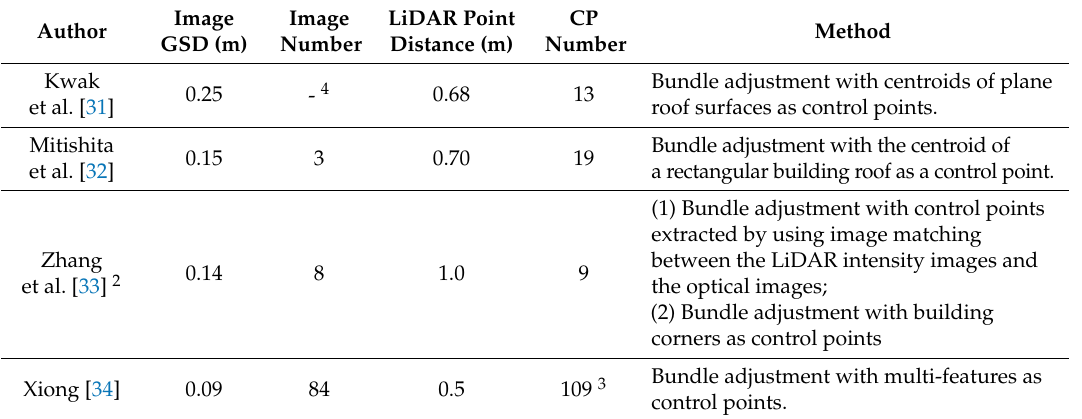
Table 4. Information on the data and the methods of some other authors for the registration 1 .